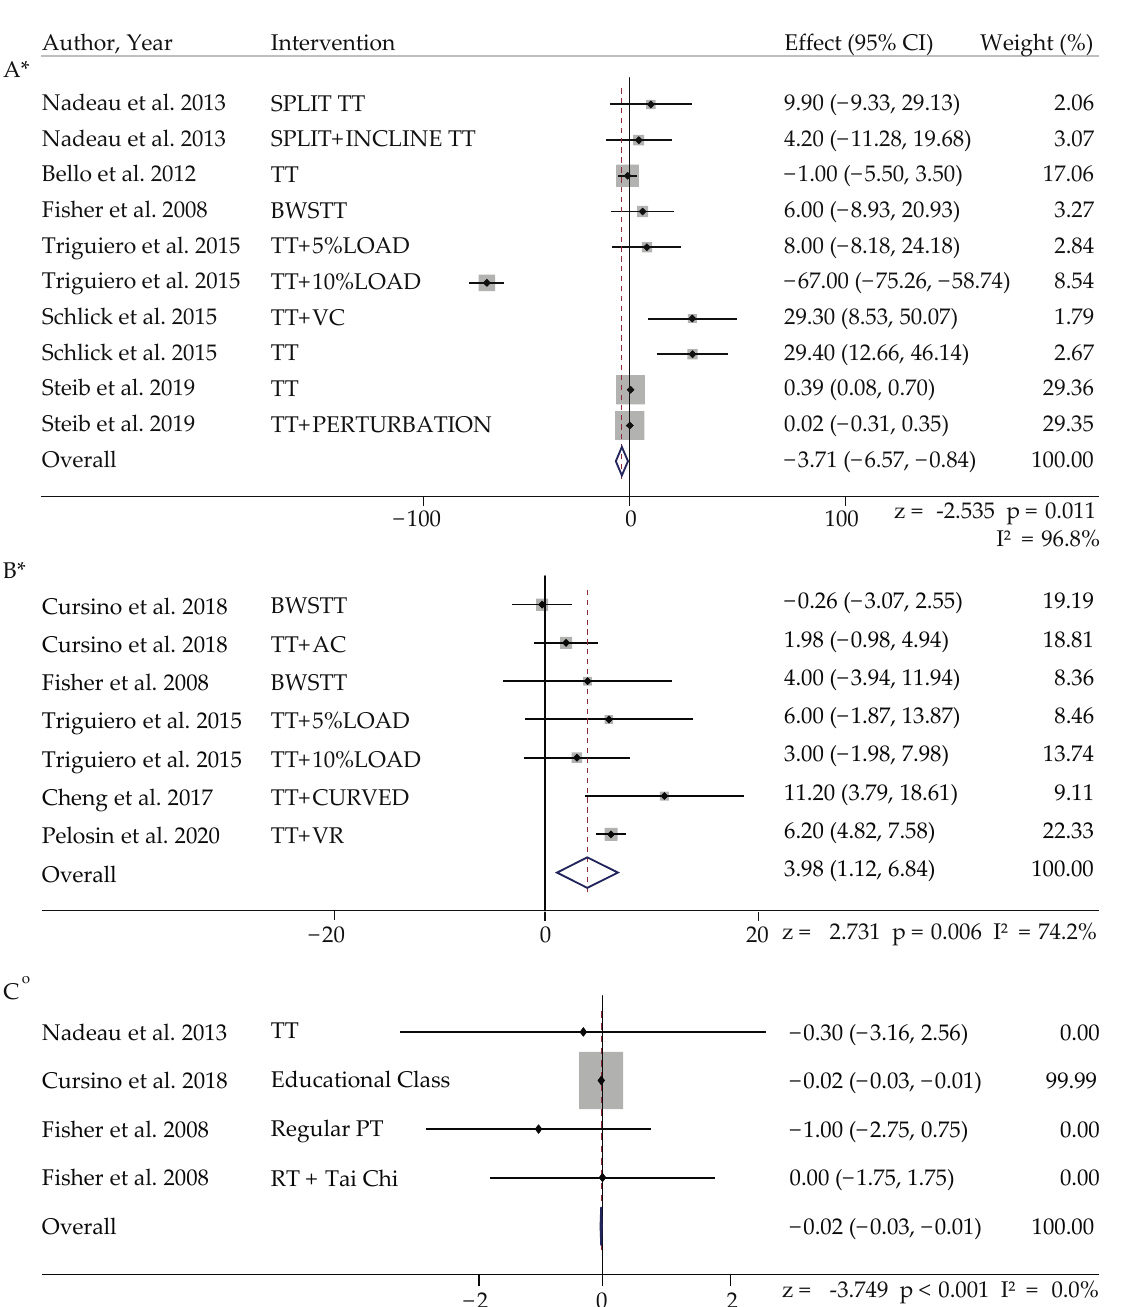
Figure 3. Forest plot of Parkinson’s disease: ( A ) stride length; ( B ) step length; ( C ) step width. Note: *—random effect model; ◦ —fixed effect model. Abbreviations: TT: treadmill training, BWSTT: